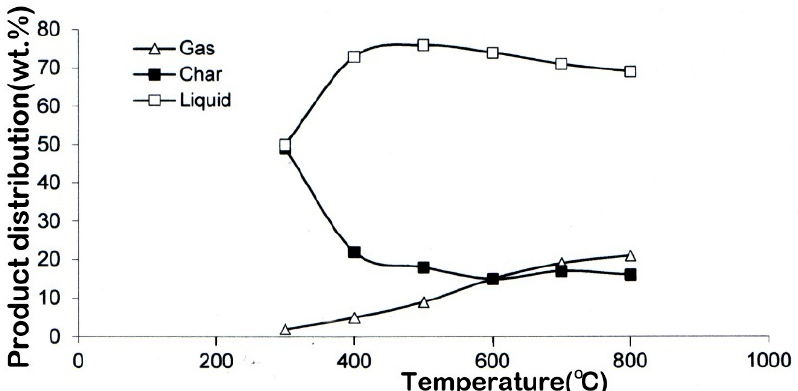
Figure 4. Temperature effect on product distributions (slow pyrolysis; moisture content, 48.15 wt.%; stripping gas flow rate, 40 L/h).